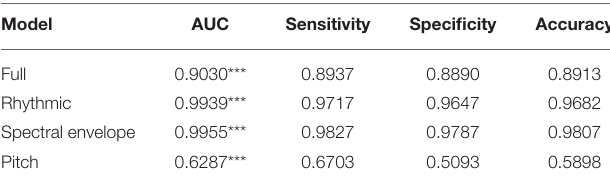
TABLE 2 | Classification results, expressed as median area-under-the-curve (AUC) values, Sensitivity, Specificity, and Accuracy for each model. Model AUC Sensitivity Specificity Accuracy